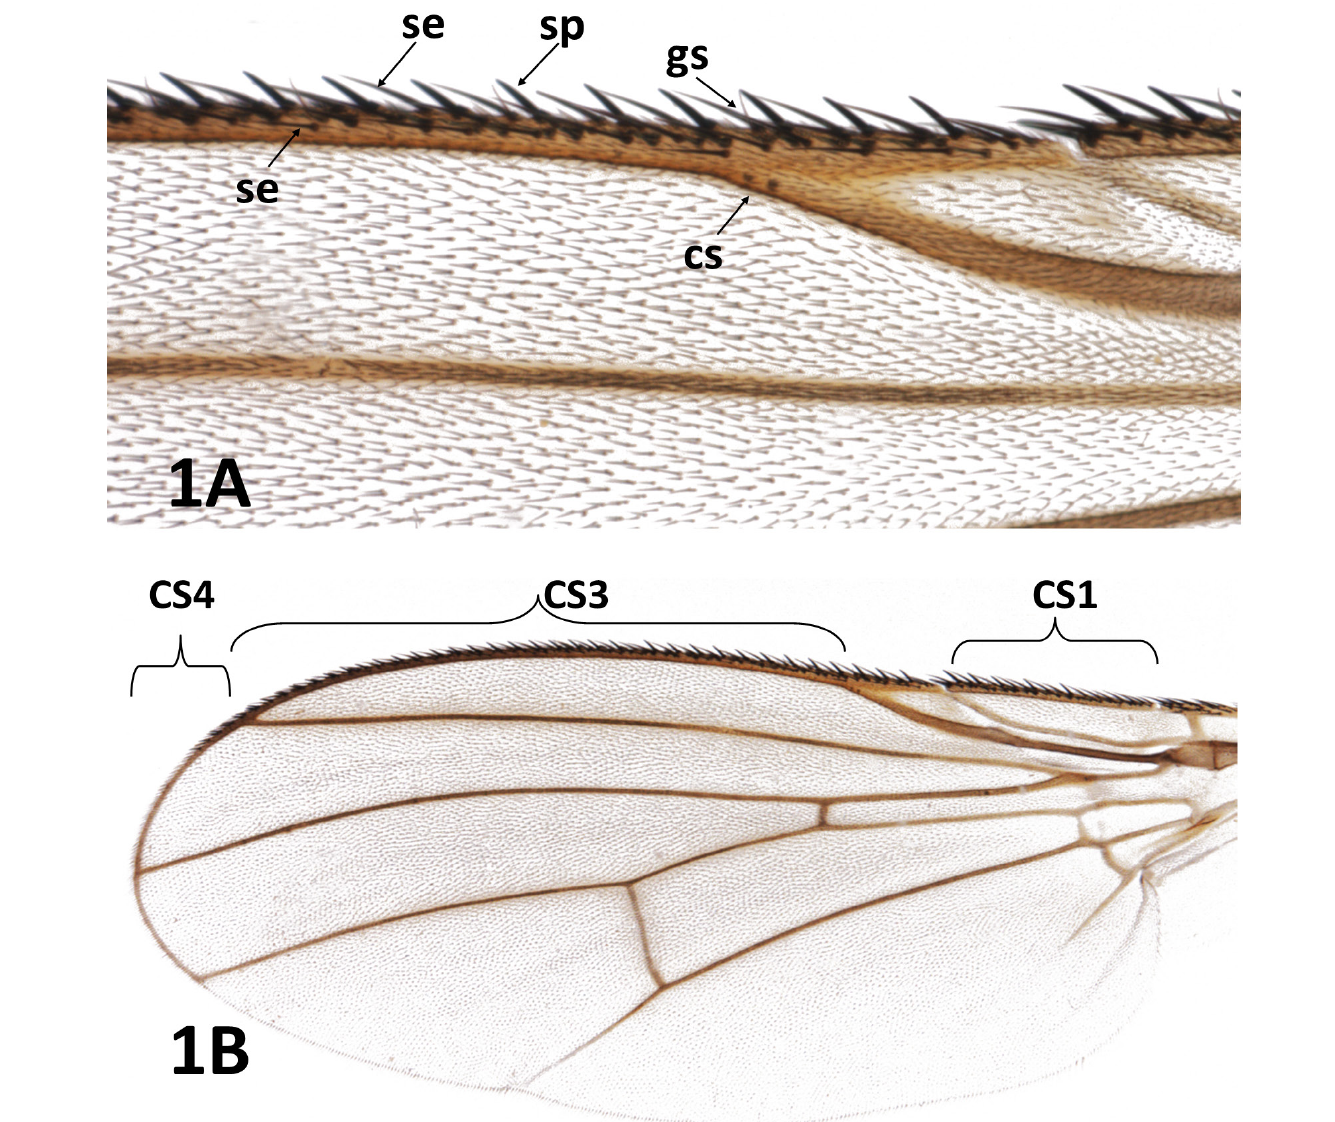
Fig. 1. Coenosia pudurosa Collin, 1953, ♀. A . Detail of wing, ventral view, showing different kinds of macrotrichia: cs = campaniform sensillum; gs = gustatory sensillum; se = setula; sp = spinule. B . Wing, ventral view showing costal sectors 1‒4: CS = costal